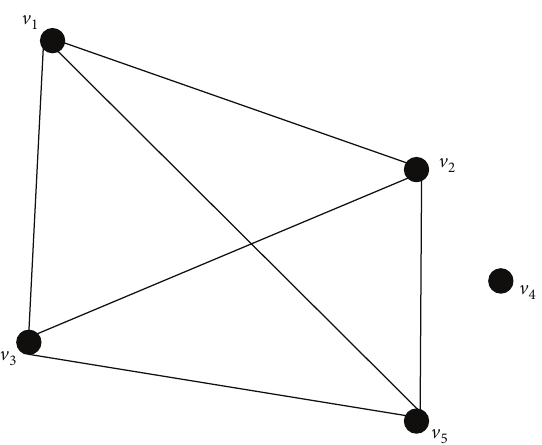
Figure 1: Illustration of a graph with 𝑁 = 5 nodes and 6 edges, where the edge set is 𝐸 = {( V 1 , V 2 ),( V 1 , V 3 ), ( V 1 , V 5 ), , V ),( V , V ),( V , V )} and 𝑁( V ( V 2 3 2 5 3 5 ) = { V , V , V } , 𝑁( V ) is an empty set, and 𝑁( V 𝑁( V 3 1 2 5 4 The shortest path length of nodes V 1 and V 2 is 1.